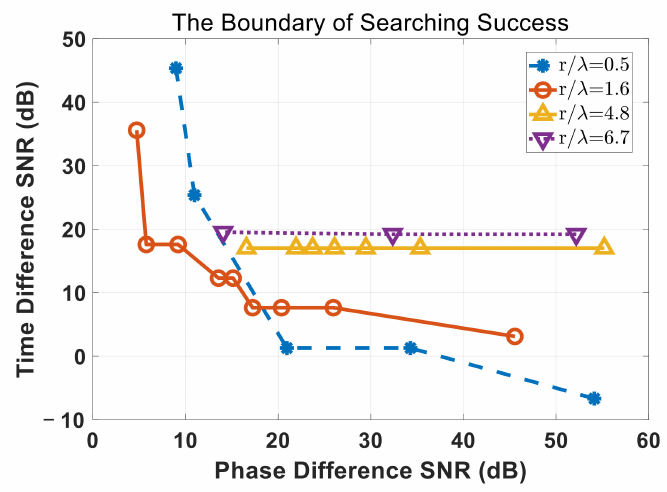
Figure 9. The boundary of searching success of different ratio r / λ